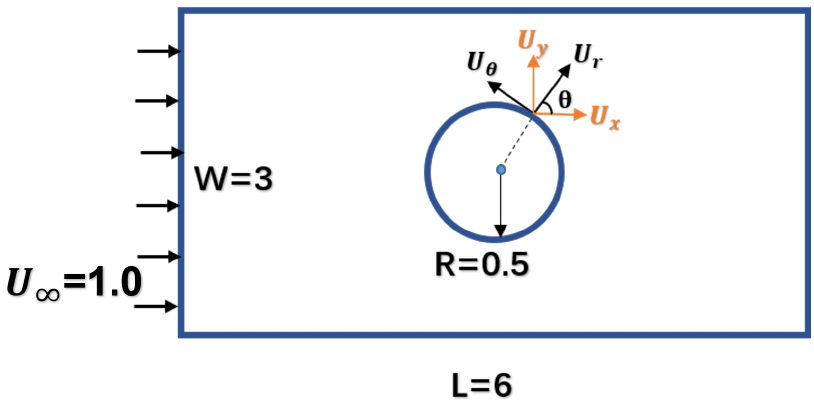
Figure 3. Schematic for potential flow over circular cylinder. To approximate the flow field inside the computational domain, 2000 spatial points were randomly sampled inside the domain, as is shown in Figure 5. Here the predicted flow field is used to evaluate how well it satisfies the Laplacian equation. The residue R PDE at each point was summed up to quantify the deviation of the prediction from true solutions. The satisfaction of the imposed boundary conditions was evaluated at the 400 data points sampled at the boundaries, i.e., the left, right, bottom and top boundary of the rectangular domain and the surface of the